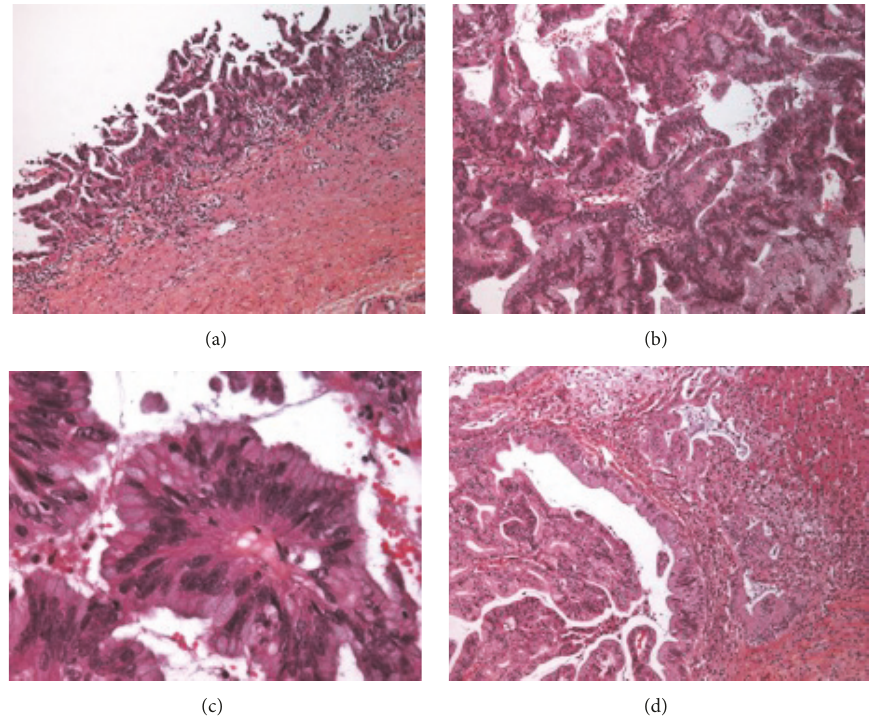
Figure 4: Histopathology. (a) Endocytic adenocarcinoma x10. (b) Adenocarcinoma bud x10. (c) Adenocarcinoma bud x40. (d) Degeneration of the liver